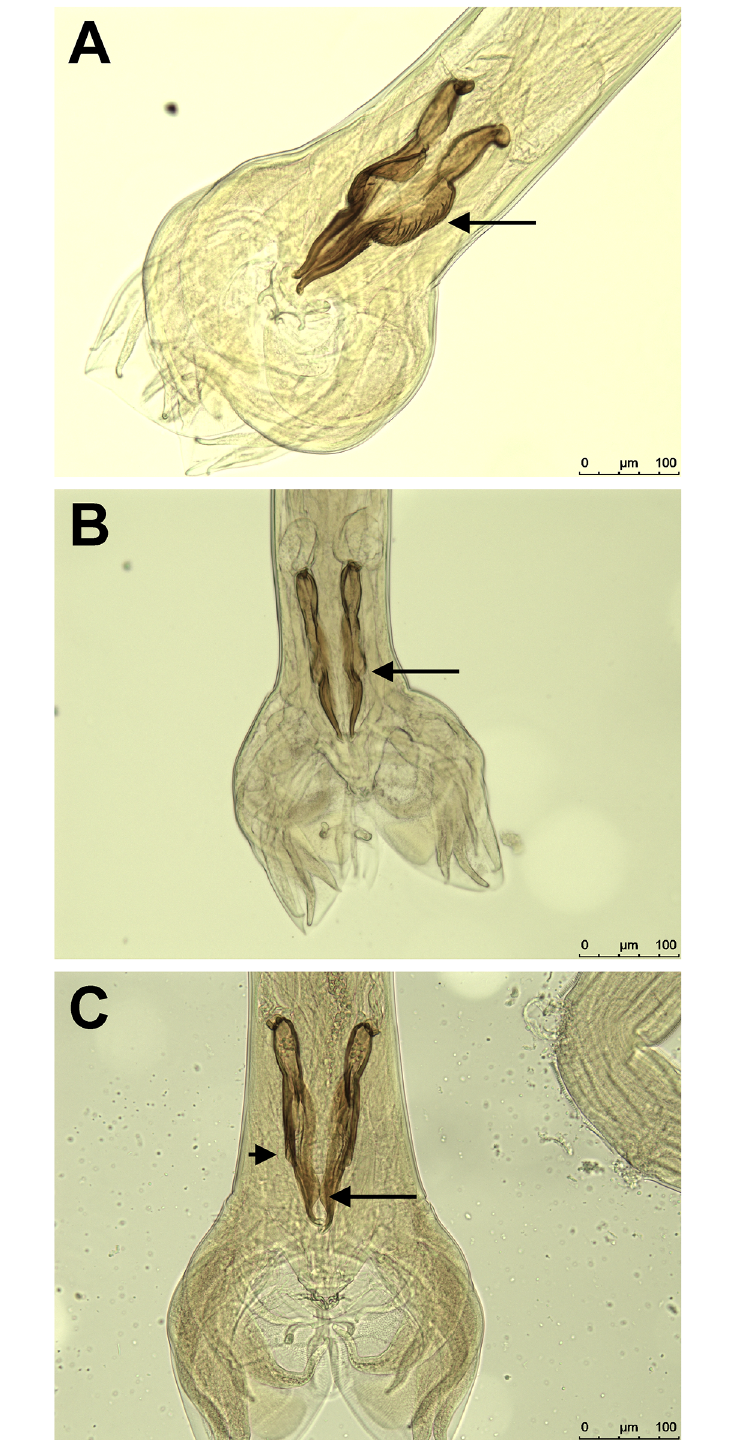
Fig 1. Ventral view of spicules of Cooperia spp. from a Brazilian calf. (A) Cooperia pectinata males have large spicules with corrugated edges in the middle third (arrow). (B) Cooperiapunctata spicules show a large concavity near the middle, which has a distinct border and a lateral narrow projection. (C) Cooperia spatulata spicules have a small concavity (small arrow) and a large ventral flange (large arrow).